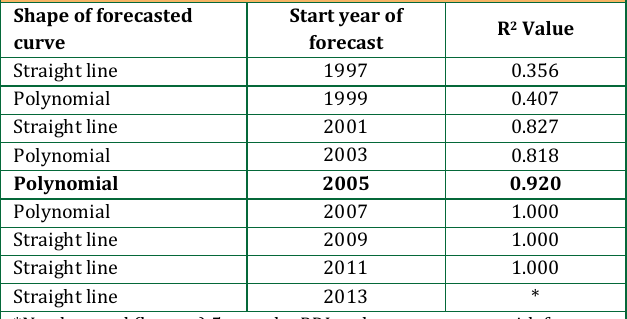
Figure 9: Plot of known values of the 5-month eRDI st against the known values of the 5-month eRDI st that produced the best performing forecasting model. Table 8: Progressive training and testing of forecasting model for eRDI st future trends